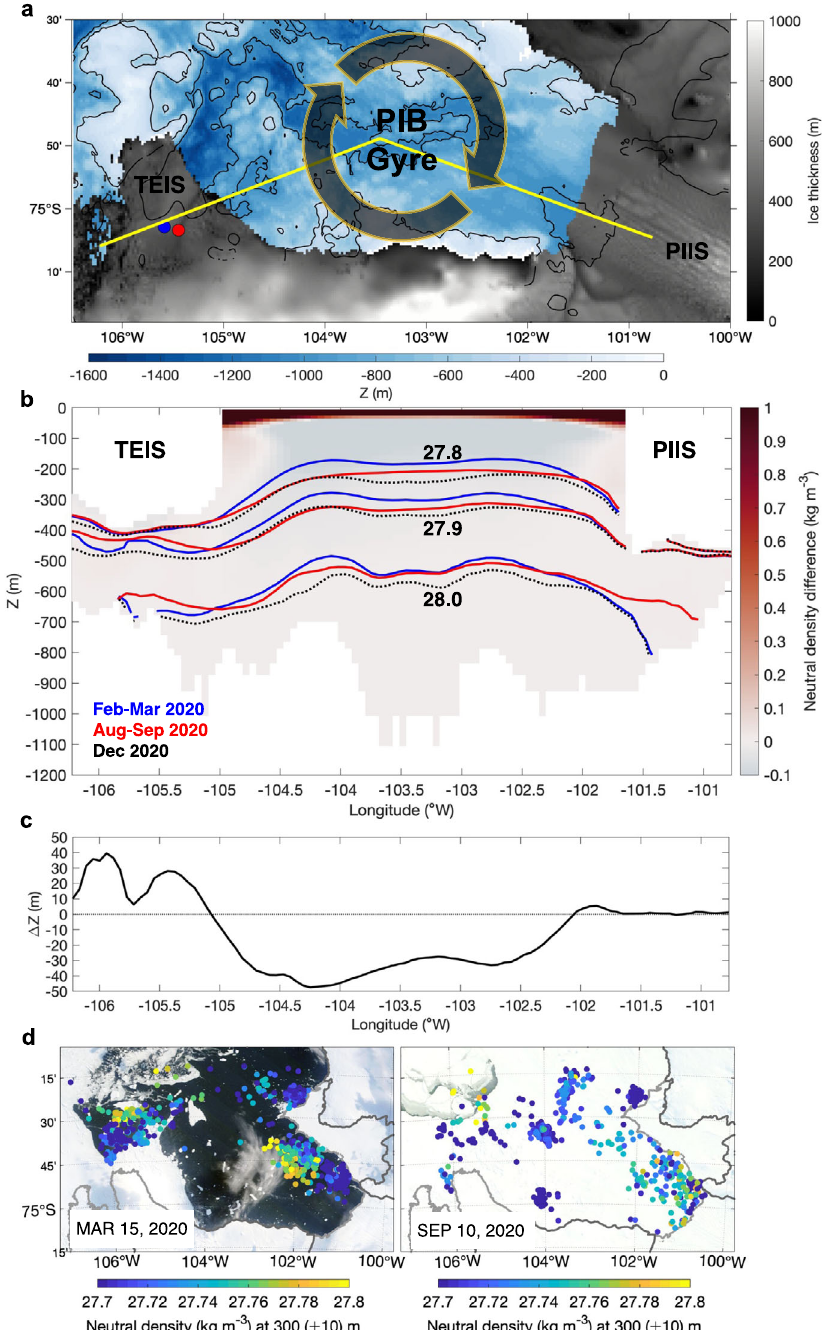
Fig.7|RegionaloceansimulationshowingthevariabilityofthePineIslandBay (PIB) gyre density structure. a Location of the section used in panel b and the AMIGOS3a (blue) and AMIGOS3c (red) moorings. Ice thickness and bathymetry from BedMachine Antarctic v2, ref. 37. Thwaites Eastern Ice Shelf (TEIS) and Pine Island Ice Shelf (PIIS) are identi fi ed in the map. Note that BedMachine is not updated to the most recent calving front. A schematic location of the PIB gyre is shown by the arrows. b Vertical section showing the difference in neutral density betweenAugust-September2020(redlines)andFebruary – March2020(bluelines) to illustrate the density variation in the sea-ice-covered and sea-ice-free periods, respectively. During a sea-ice-covered period, the isopycnals deepen at the centre